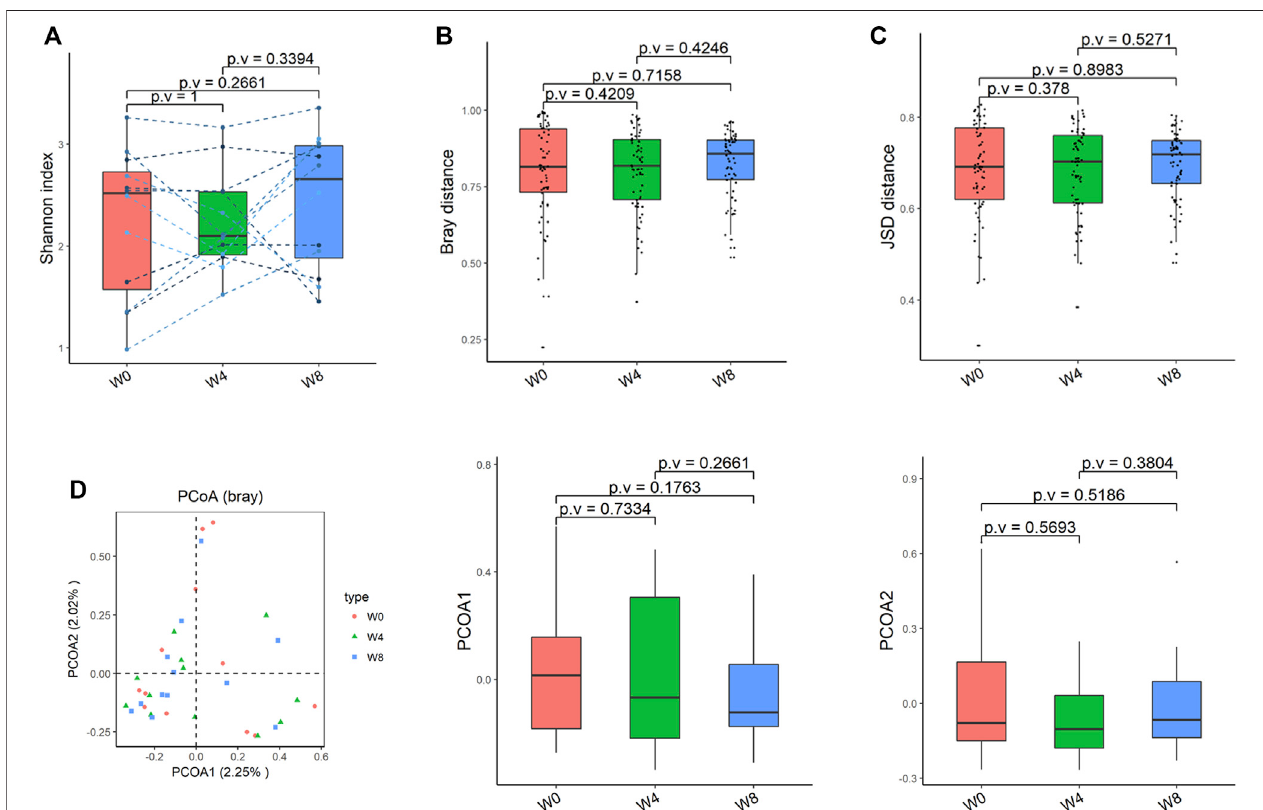
FIGURE 3 | Alpha-diversity, beta-diversity, and principal component analysis at the species level. (A) Shannon index was not signi fi cantly different in comparisons betweenW0andW4,W0andW8,andW4andW8. (B) Nosigni fi cantdifferenceinbetadiversitybasedonBray-Curtis(Bray)distanceforW0vsW4,W0vsW8,andW4 vs W8. (C) The Jensen-Shannon Divergence (JSD) distance-based beta diversity was not signi fi cantly different in W0 vs W4, W0 vs W8, and W4 vs W8. (D) PCoA analysis based on Bray distance showed that the fi rst principal component was not signi fi cantly different in W0 vs W4, W0 vs W8, and W4 vs W8, nor the second